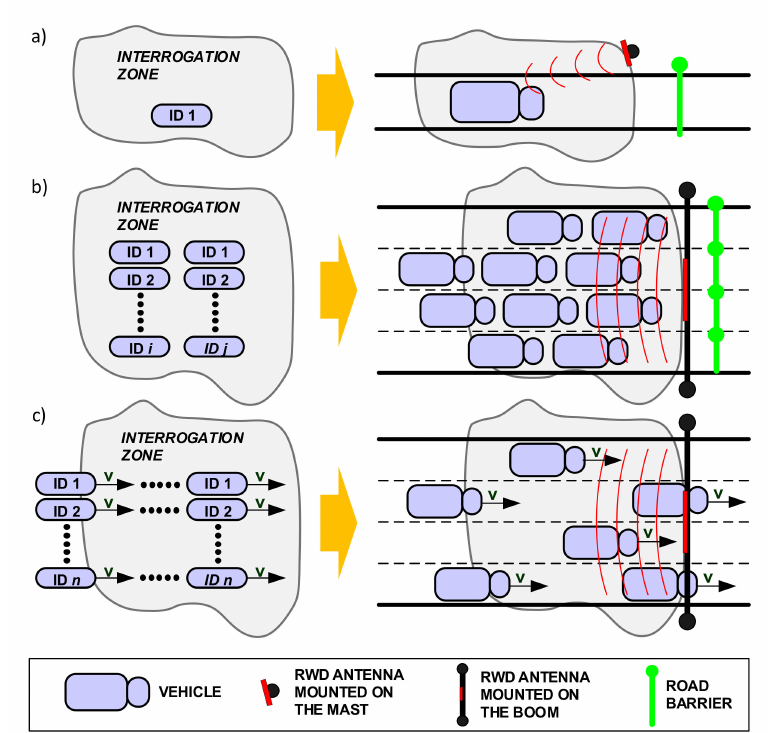
Figure 4. RFID identification modes: ( a ) single identification; ( b ) multiple identification; ( c ) dynamic